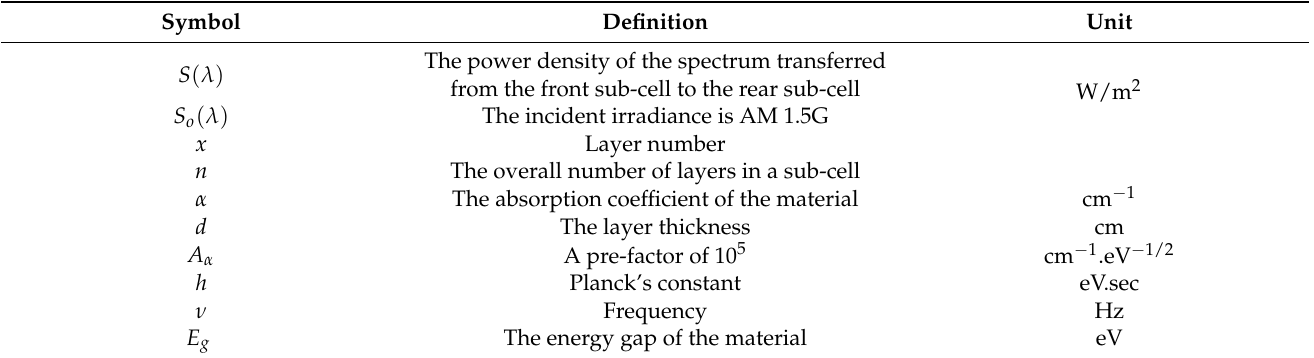
Table 1. Key incident and transmitted spectrum